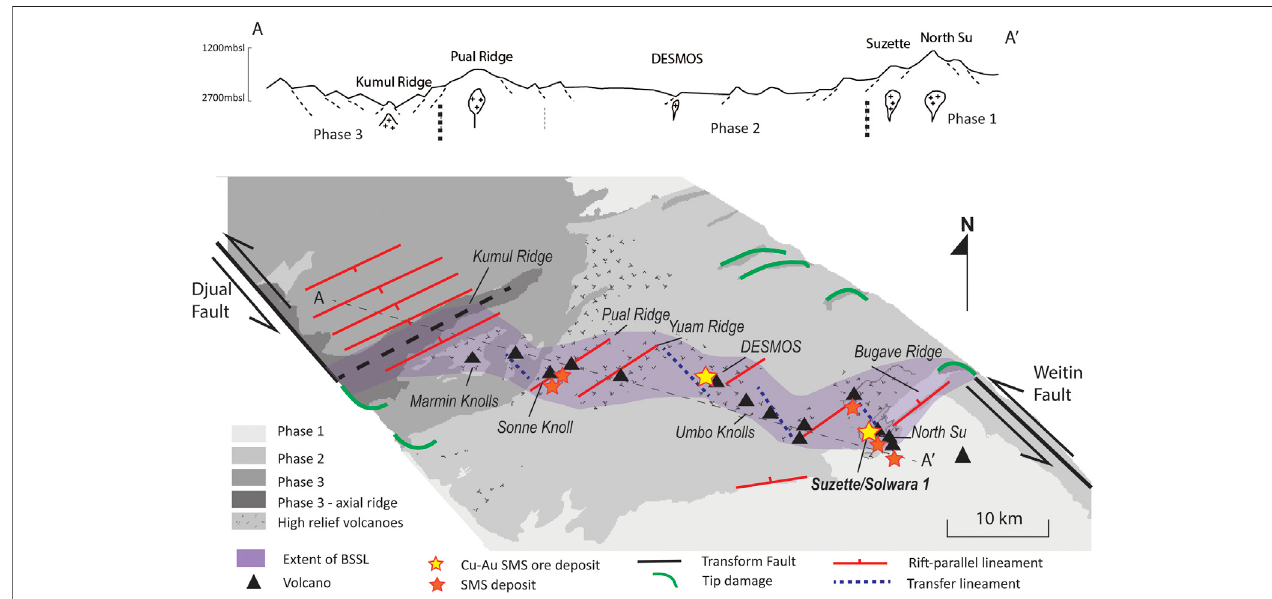
FIGURE 14 | Schematic summary of the current rift phases and trace of the of Bismarck Sea Seismic Lineament (BSSL) through the EMB. The BSSL accommodationzoneishighlightedalongwitheachriftingphase.Thesymbolsarethesameasthoseusedin Figure13 forcomparison.Thetopcross-sectionalongthe BSSListoscaleandshowsinterpretednormalfaulttraces.Thestars,highlightingtheSMSdeposits,indicatetheirdistributionthroughtheEMB;thelocationofSolwara1 is highlighted at the transition between Phase 1 and Phase 2, within the accommodation zone/BSSL.